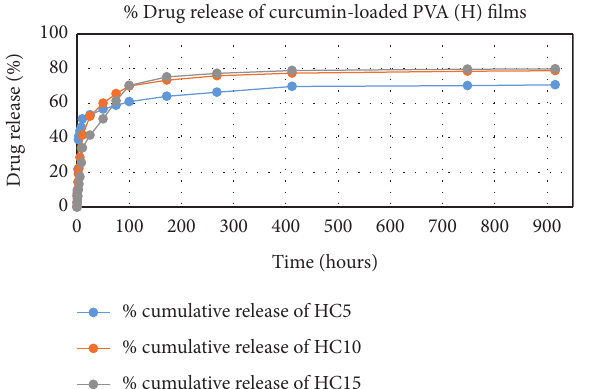
Figure 14: % Drug release % of magnolol-loaded PVA (H) films.